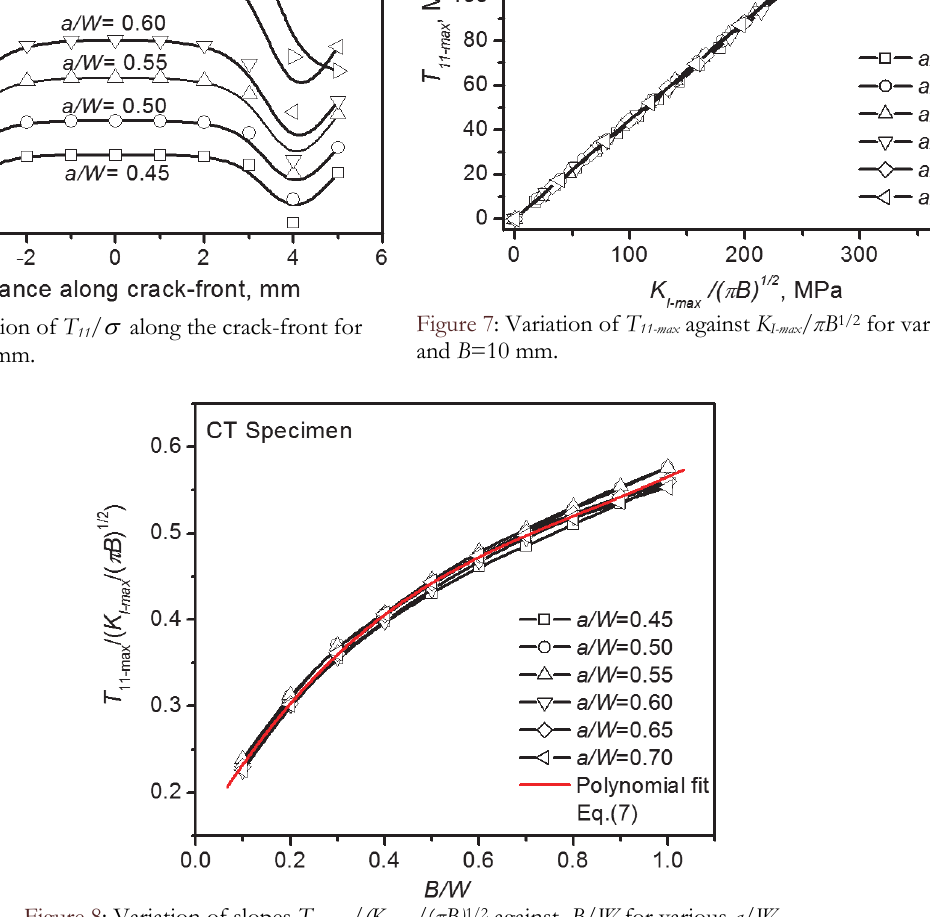
Figure 8: Variation of slopes T 11-max /(K I-max /( π B) 1/2 against B/W for various